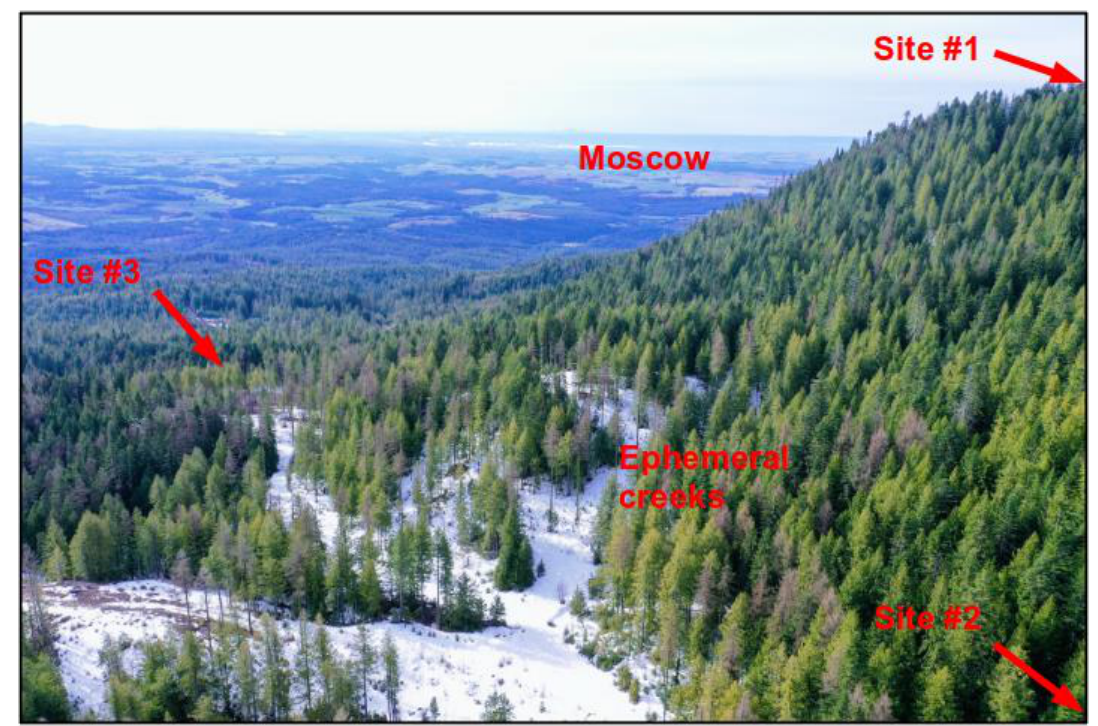
Figure 2. Sample collection locations along the eastern Palouse Range from a drone view looking towards Moscow, Idaho, USA.